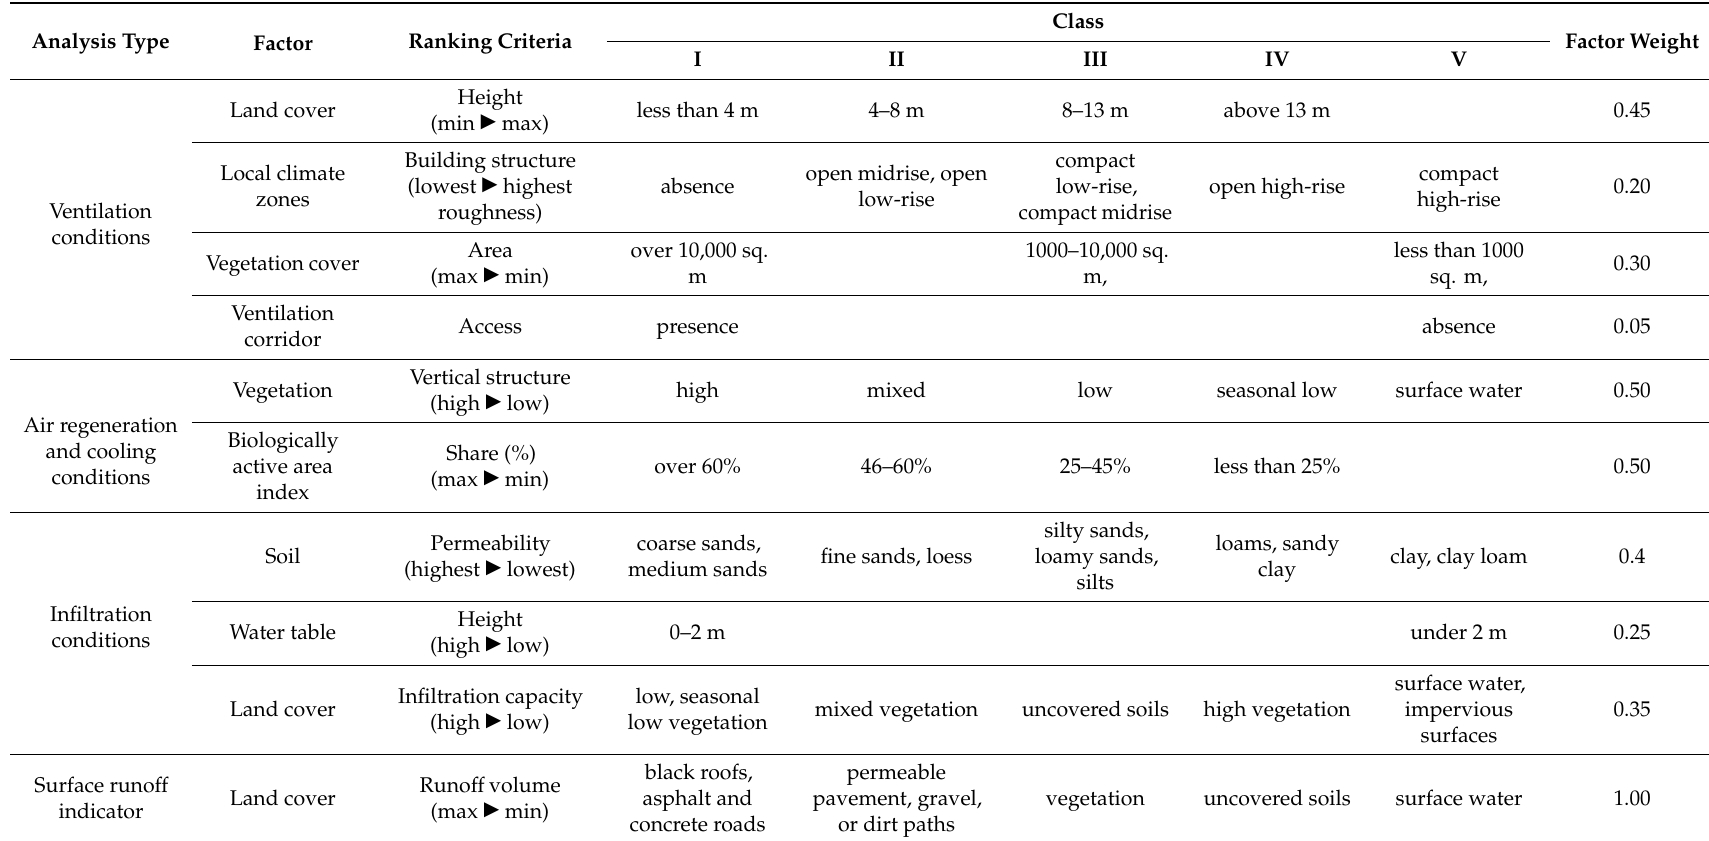
Table 2. Methodology for natural performance analysis of climatic and hydrological functioning of Warsaw